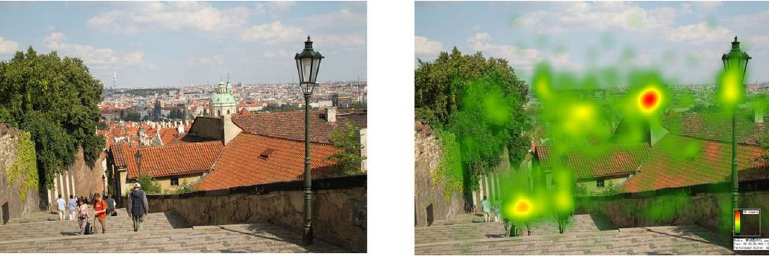
Fig. 11 The comparison of eye motion and heatmap for a street scene having